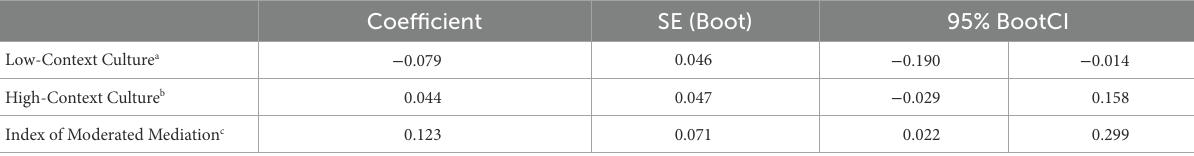
TABLE 3 Conditional indirect effects and index of moderated